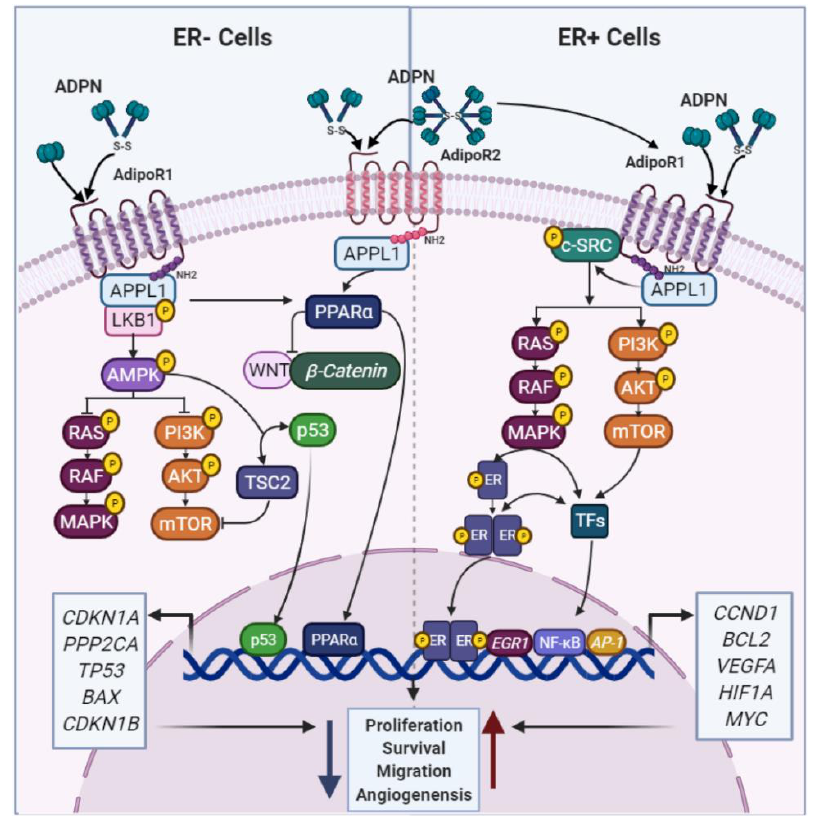
Figure 2. ADPN effects in BC cells. ADPN isoforms and their receptors regulate several signaling pathways to control BC cell behavior. However, it has been reported that ADPN can have anti- or pro-oncogenic effects depending on the ER status. PPARα—peroxisome proliferator activated